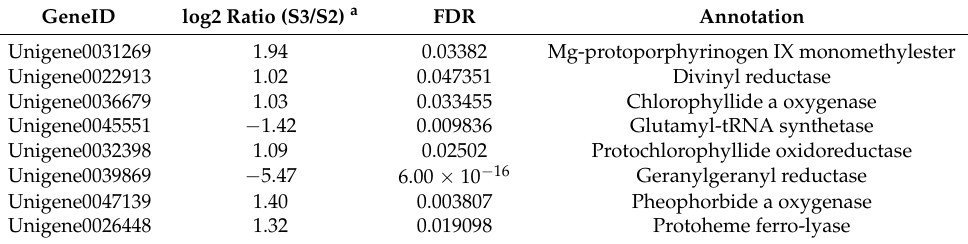
Table 3. Putative chlorophyll genes identified from differentially expressed genes.